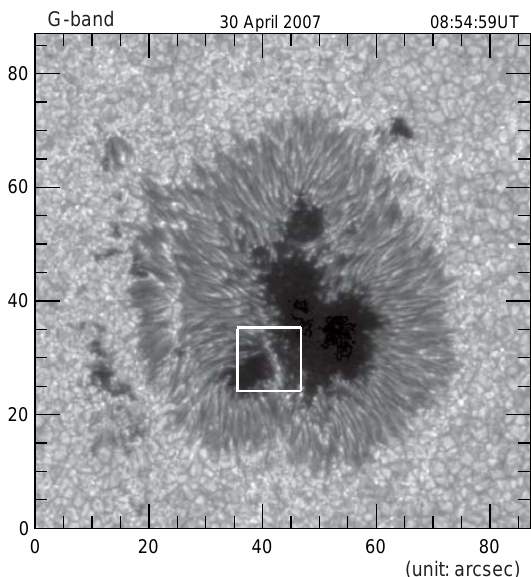
Figure 12: G-band image of a well-developed sunspot in NOAA Active Region 10953. The white box encloses a well-developed light bridge. Image reproduced with permission from Shimizu et al. (2009), copyright by